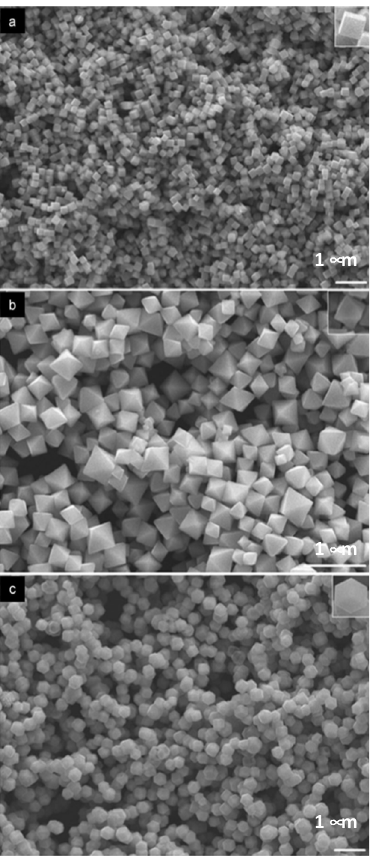
Figure 12. SEM images of ( a ) cubic, ( b ) octahedra and ( c ) rhombic dodecahedra Cu 2 O nanocrystals synthesized by Huang and co-workers [216]. Reproduced from [216] with permission from Wiley.